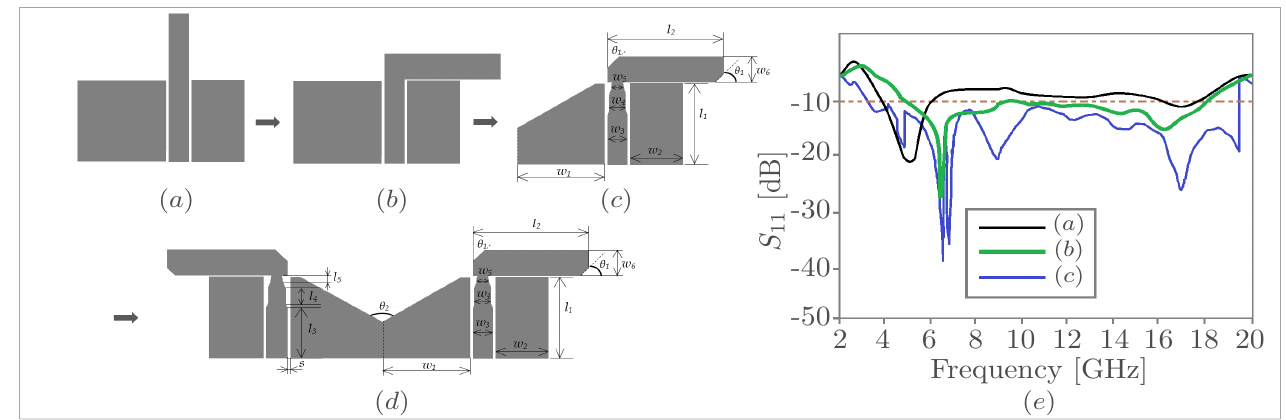
FIGURE 4: The Design steps of the proposed MIMO - UWB antenna ( a ) Conventional monopole antenna with partial ground plane and asymmetric CPW -fed, ( b ) The UWB CPW -fed L -shaped (bent) antenna, ( c ) The modified UWB CPW -fed bent antenna, ( d ) The proposed MIMO UWB CPW -fed bent antenna, ( e ) The corresponding S antennas.